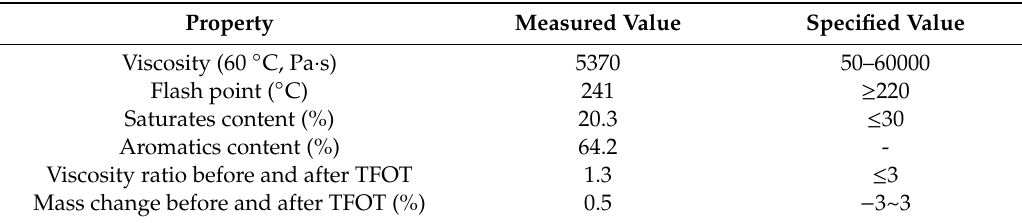
Table 3. Basic properties of RA-102#